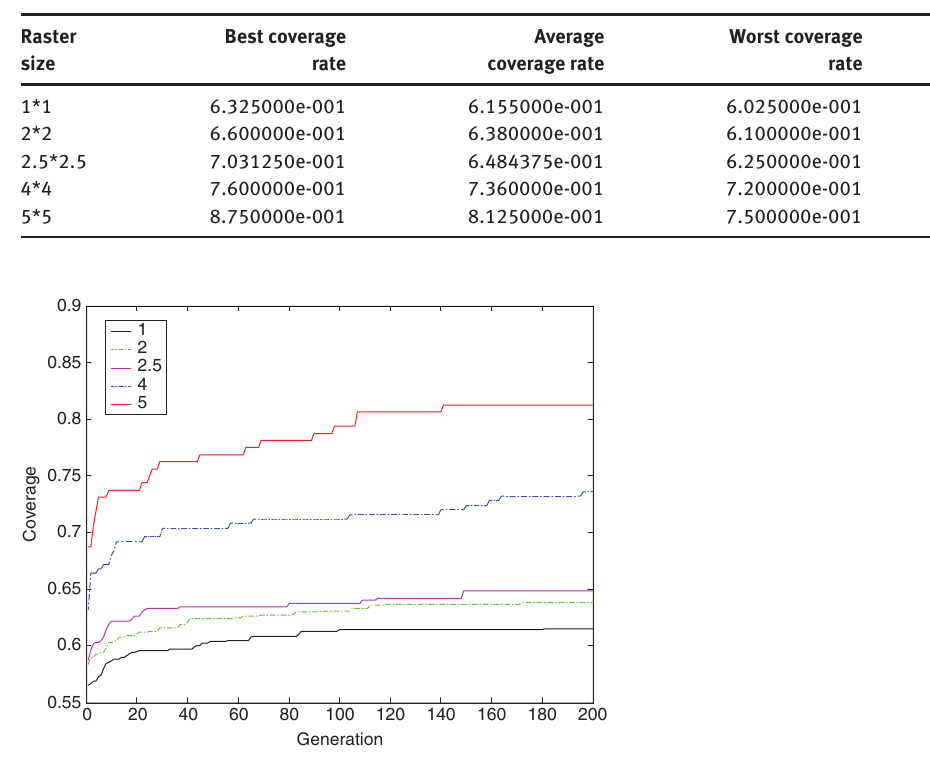
Figure 11: The Coverage Rate Curves When the Raster Was Set in Different